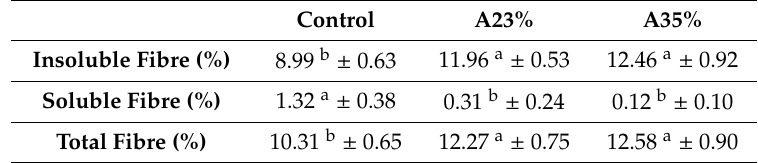
Table 3. Insoluble, soluble and total fibre of GF breads (in dry matter): control, A23% and